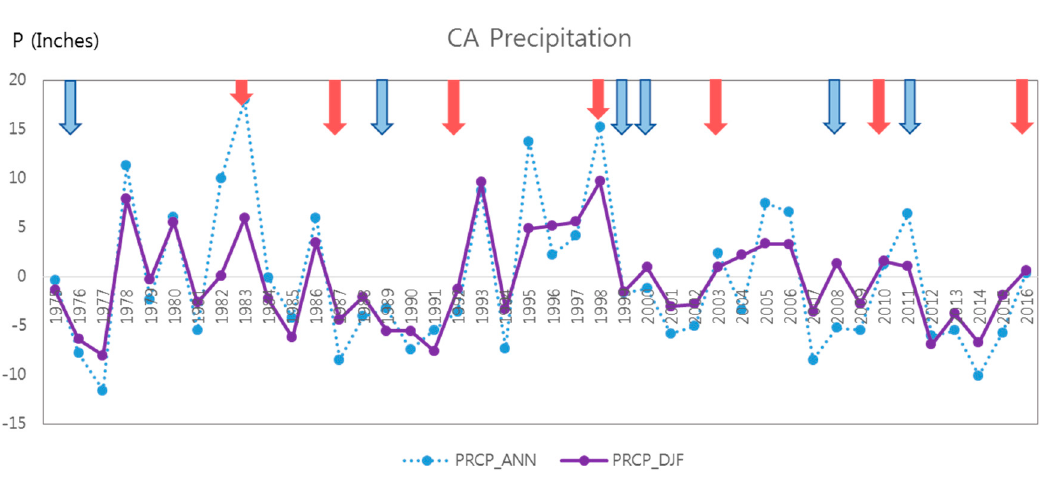
Figure 1. Forty-two-year (1975–2016) time series of annual (blue dashed line) and DJF (purple solid line) precipitation anomaly (PRCP) in CA ( y -axis in left). The red and blue arrows indicate El Niño and La Niña winters, respectively.